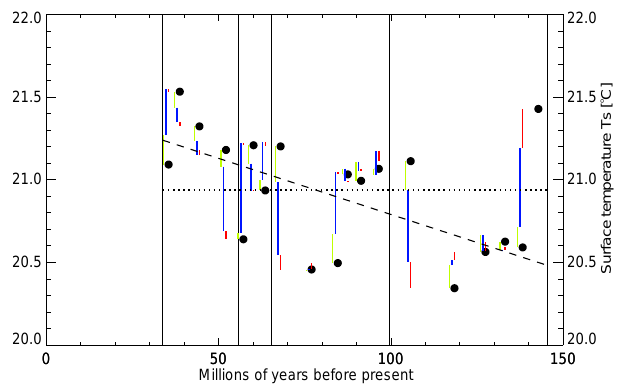
Figure 7. Global annual mean surace air temperature (at 1.5m) in each model simulation (black dots). Also shown as vertical lines is the contribution to temperature difference between each consecutive Stage, from changes over land (green), over ocean (blue), and over regions which switch between land and ocean (red). Also shown are the global mean of all simulations (dotted line), and trend across all simulations except the Berriasian (dashed line, as in Fig.